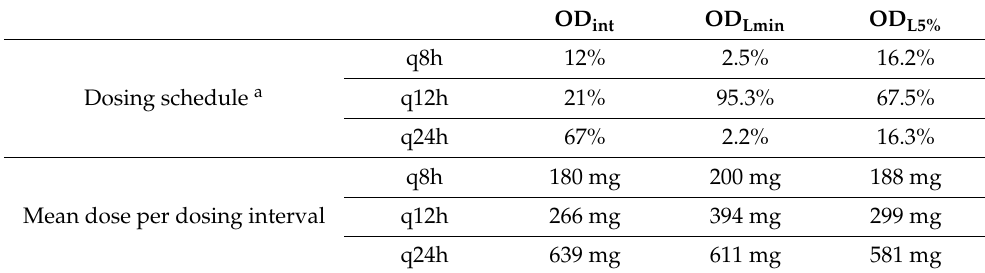
Table 2. Characteristics of dosing regimens based on the TID approach in simulated patients.